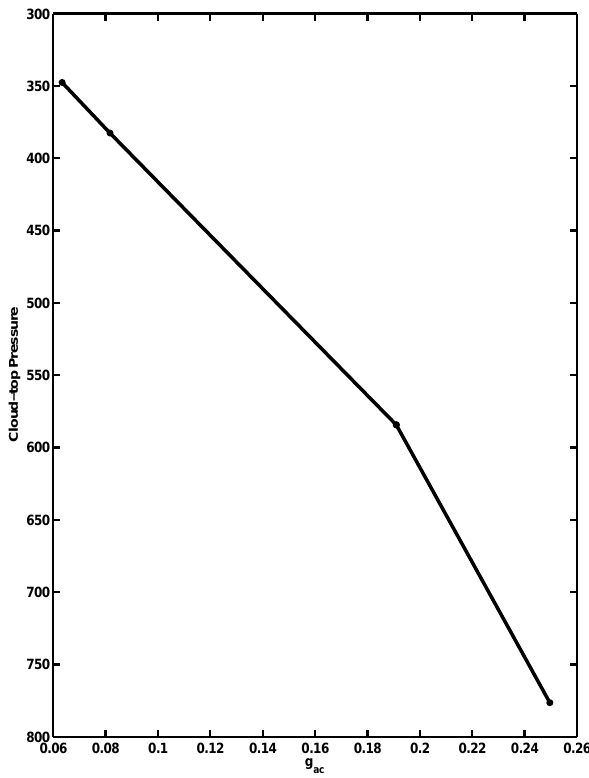
Fig. 18. Relationship between the above-cloud greenhouse param- eter and cloud-top